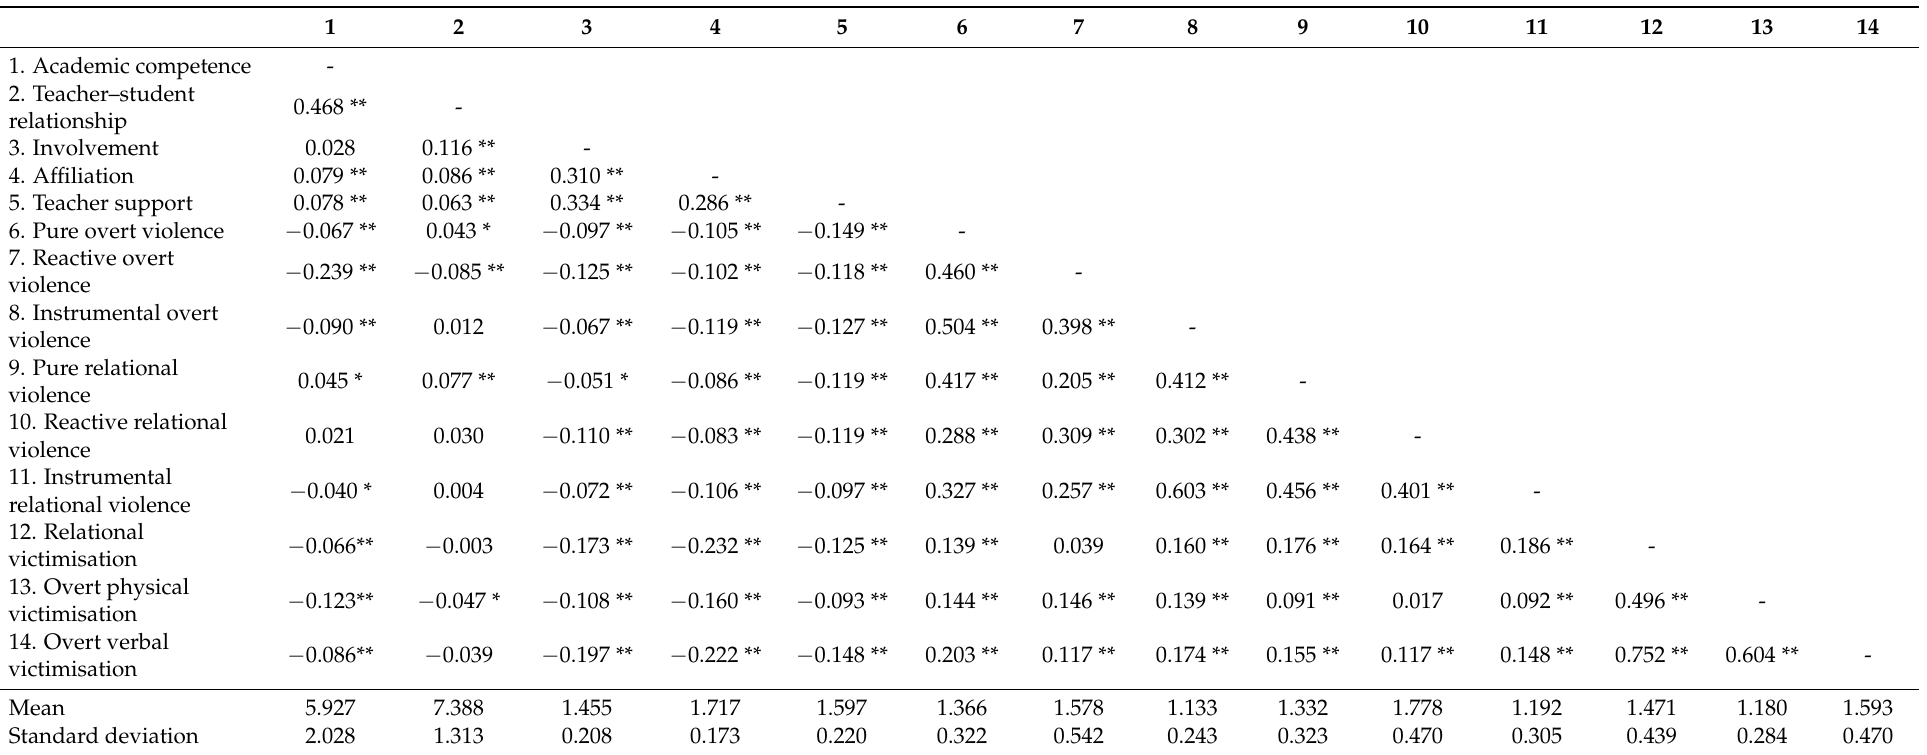
Table 2. Pearson’s correlations and descriptive statistics for observed